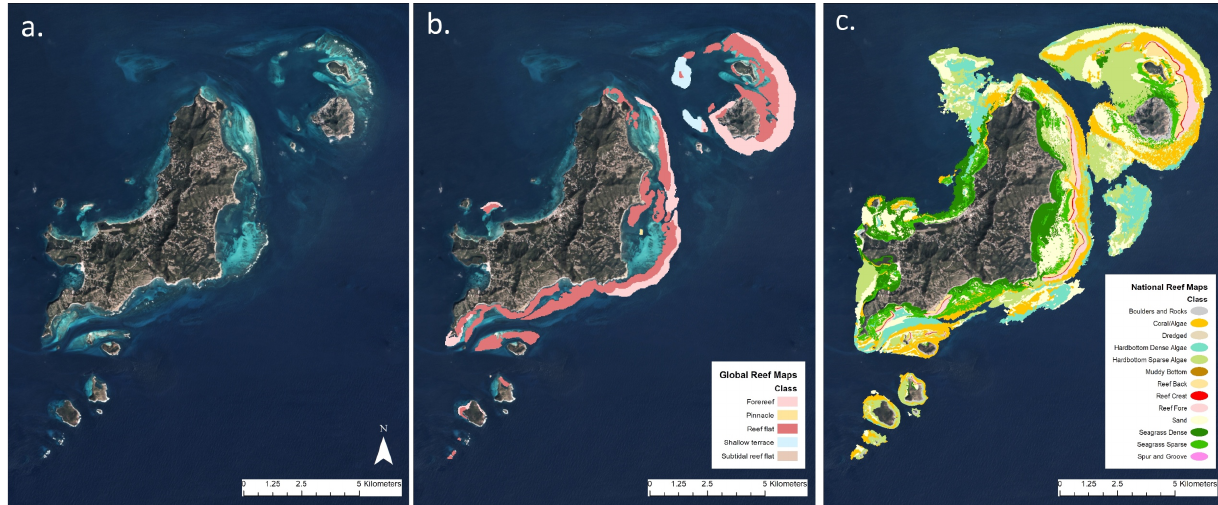
Figure 1. Comparison of multiple scale benthic habitat data around the island of Carriacou, Grenada: ( a ) PlanetScope Dove Classic imagery (4 m); ( b ) Global-scale Landsat-derived (30 m) five-class coral reef map; ( c ) National-scale PlanetScope- derived (4 m) thirteen-class benthic habitat